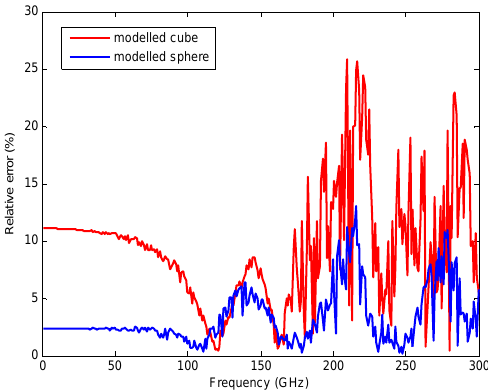
Fig.3. Maximum relative error of Cabs of randomly oriented ice cubes and ice spheres as a function of the frequency compared to the exact Mie solution of an equal volume sphere.